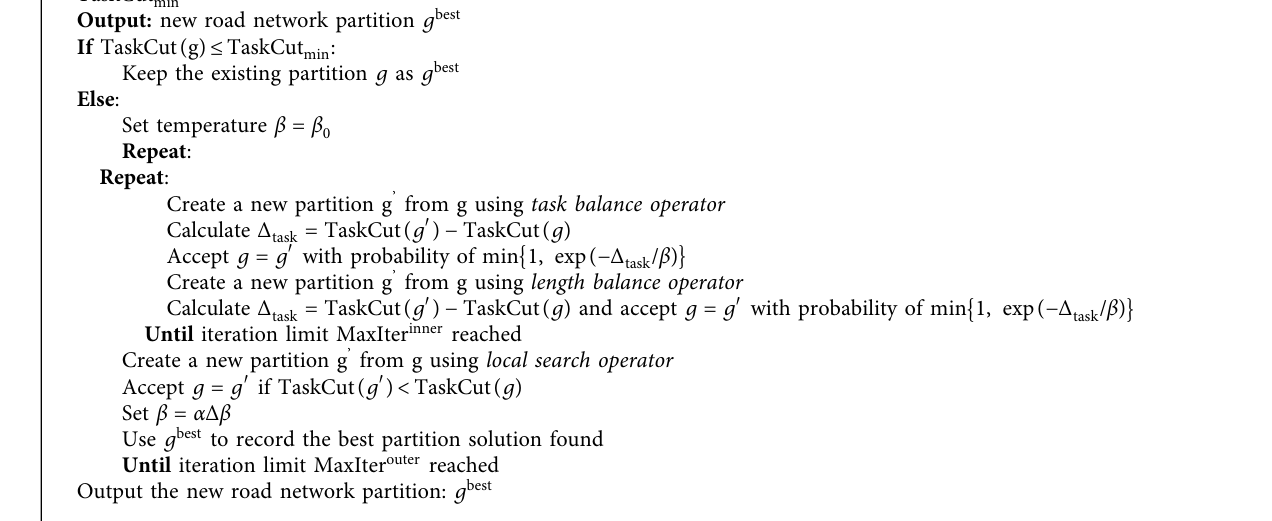
, ϕ , and ϕ are set to 100, 100, and 1 2 3